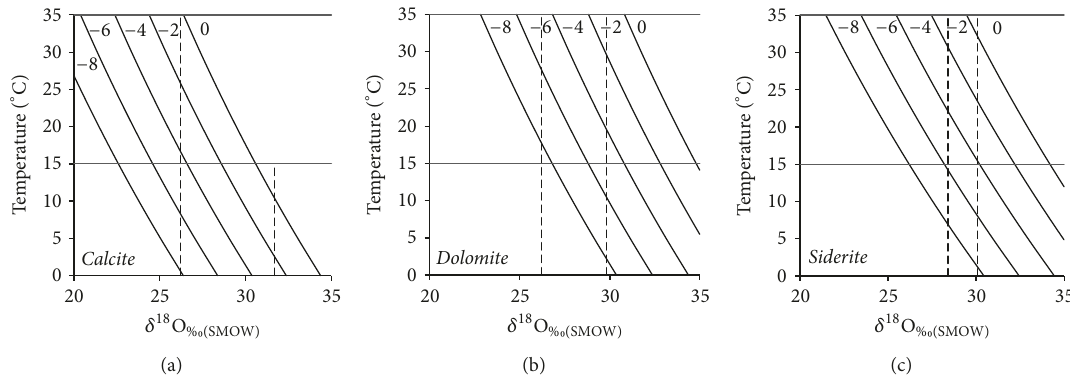
Figure 6: Temperature - 𝛿 18 O diagram in which theoretical curves are reported representing 𝛿 18 O of calcite (a), dolomite (b), and siderite (c) at equilibrium with a fluid as a function of temperature. Each curve corresponds to a fixed 𝛿 18 O fluid . 𝛿 18 O fluid of 0‰ SMOW corresponds to seawater, 𝛿 18 O fluid ranging from − 2 to − 8 corresponds to the introduction of meteoric waters in the system. The dotted lines in each diagram indicate the range of the 𝛿 18 O of analyzed carbonates. The oxygen isotopic fractionations used for the calculations are calcite-water [22], dolomite-water [23], and siderite-water